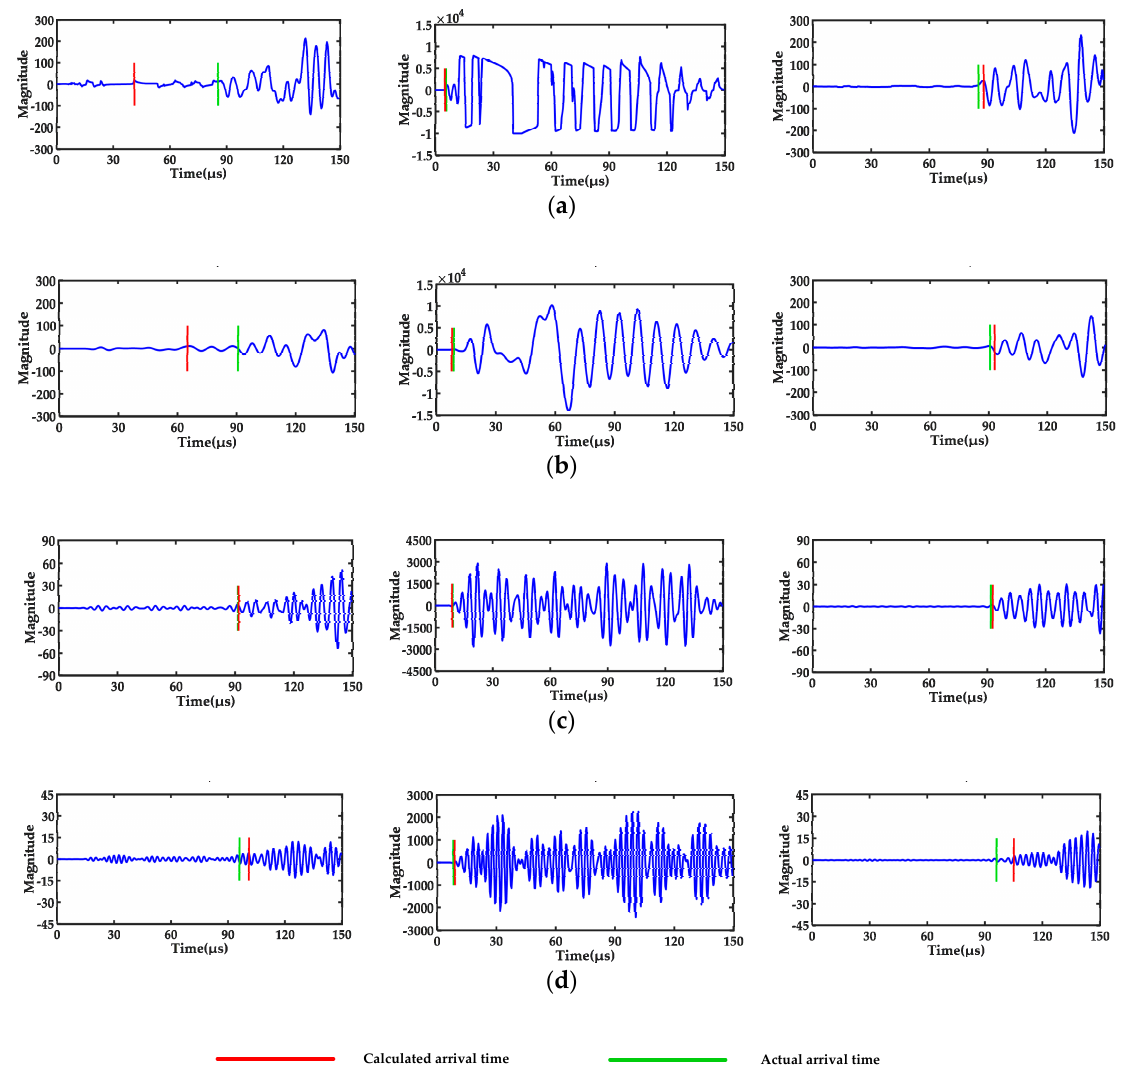
Figure 16. The comparison of the calculated arrival time and the actual arrival time of the signals with different frequency bands filtering: ( a ) signals of sensors 1–3 without filtering; ( b ) signals of sensors 1–3 with 0–100 kHz filtering; ( c ) signals of sensors 1–3 with 100–200 kHz filtering; ( d ) signals of sensors 1–3 with 200–300 kHz filtering.